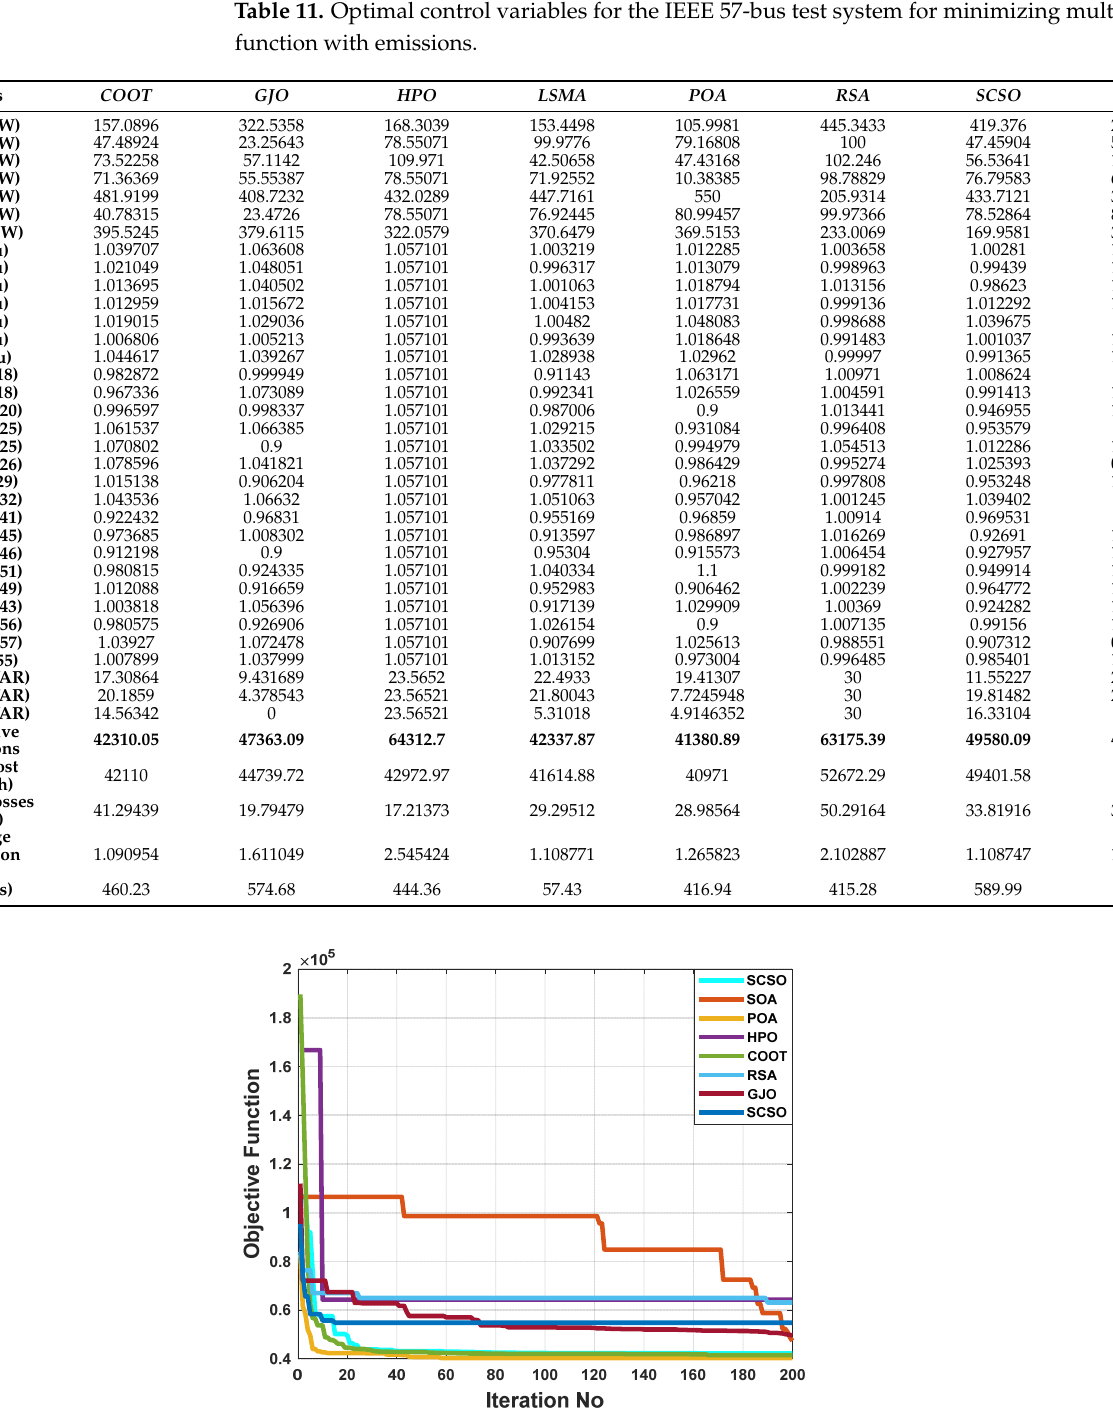
Figure 30. Boxplot of POA and other compared algorithms for case 5 in a standard IEEE 57-bus test system. 4. Conclusions In order to address the OPF issue, this study proposes a novel optimization method inspired by peafowl (Pavo muticus/cristatus) called POA. Peafowl swarms demonstrate distinct courting, food-seeking, and chasing behaviors. The following is a summary of the major innovations made in this paper and its results: (a) POA combines global and local exploitation and exploratory searching operators to achieve a reasonable trade-off be- tween the two, and to prevent local optimum formation. There are many examples of pea- cocks performing rotation dancing operations, peahens and peafowl cubs using adaptive search behavior at various stages of their search, and interactions among peacock species. (b) Instead of remaining motionless, the five peacocks that represent the most effective solutions for today will rotate and dance as they search for solutions throughout the area. Peacocks have a unique rotating dance mechanism that includes two distinct modes of rotation: spinning in-situ and circling the food source. It is significant to note that a strat- egy is used that forces the present optimal solution to perform a neighboring search which has never been done before. In this way, local optimum situations may be broken out. (c) Both peahens and peafowl cubs employ adaptive seeking and approaching mechanisms during the entire search process in order to dynamically alter their behavior at various